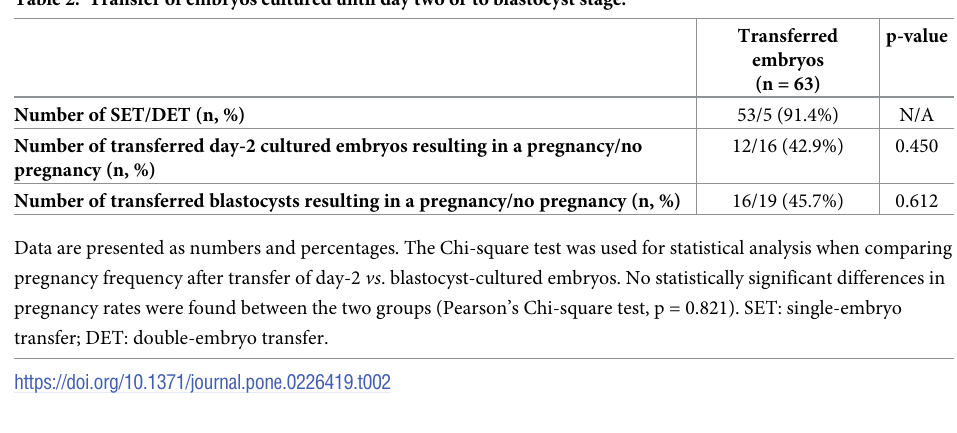
Table 2. Transfer of embryos cultured until day two or to blastocyst